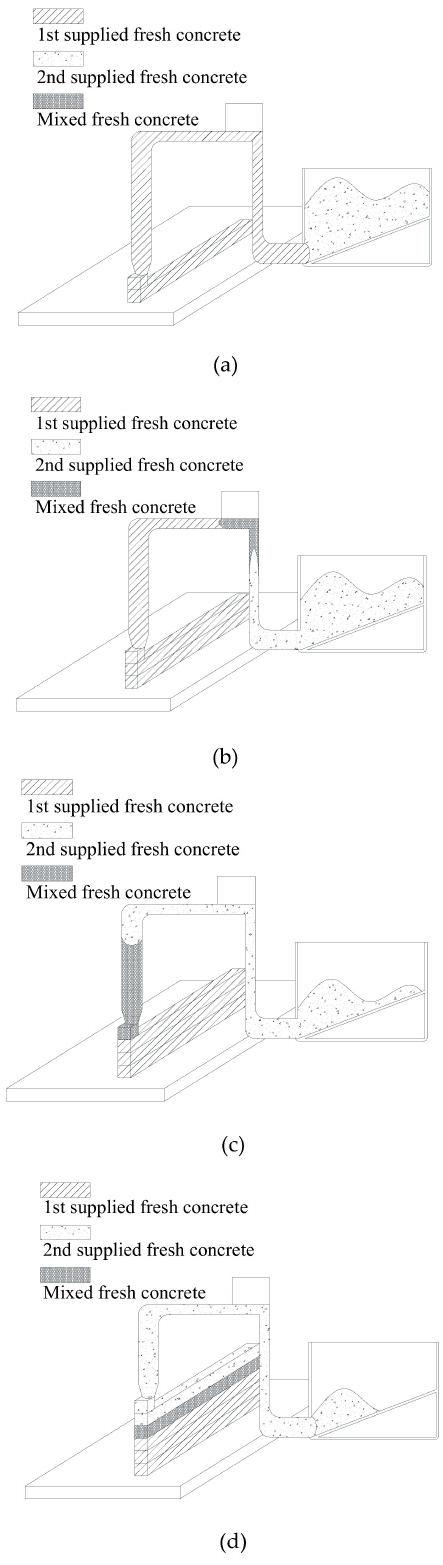
Figure 7. Extrusion phase of fresh concrete. ( a ) 1st supplied fresh concrete extrusion phase; ( b ) Fresh concrete mixing phase; ( c ) Mixed fresh concrete extrusion phase; ( d ) 2nd supplied fresh concrete extrusion